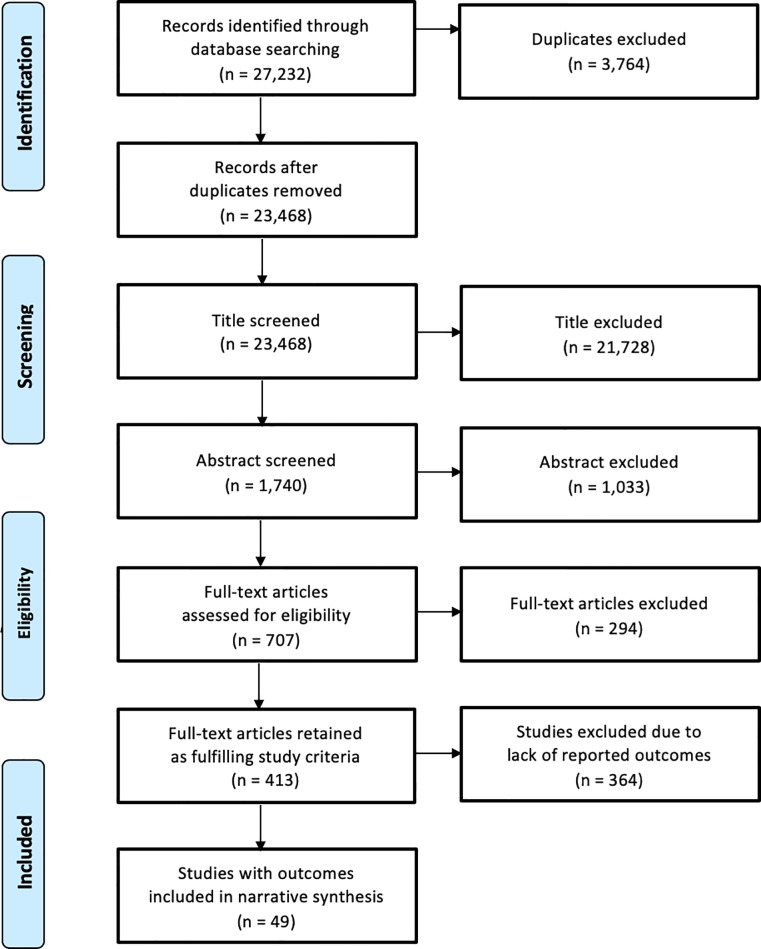
PRISMA flowchart.